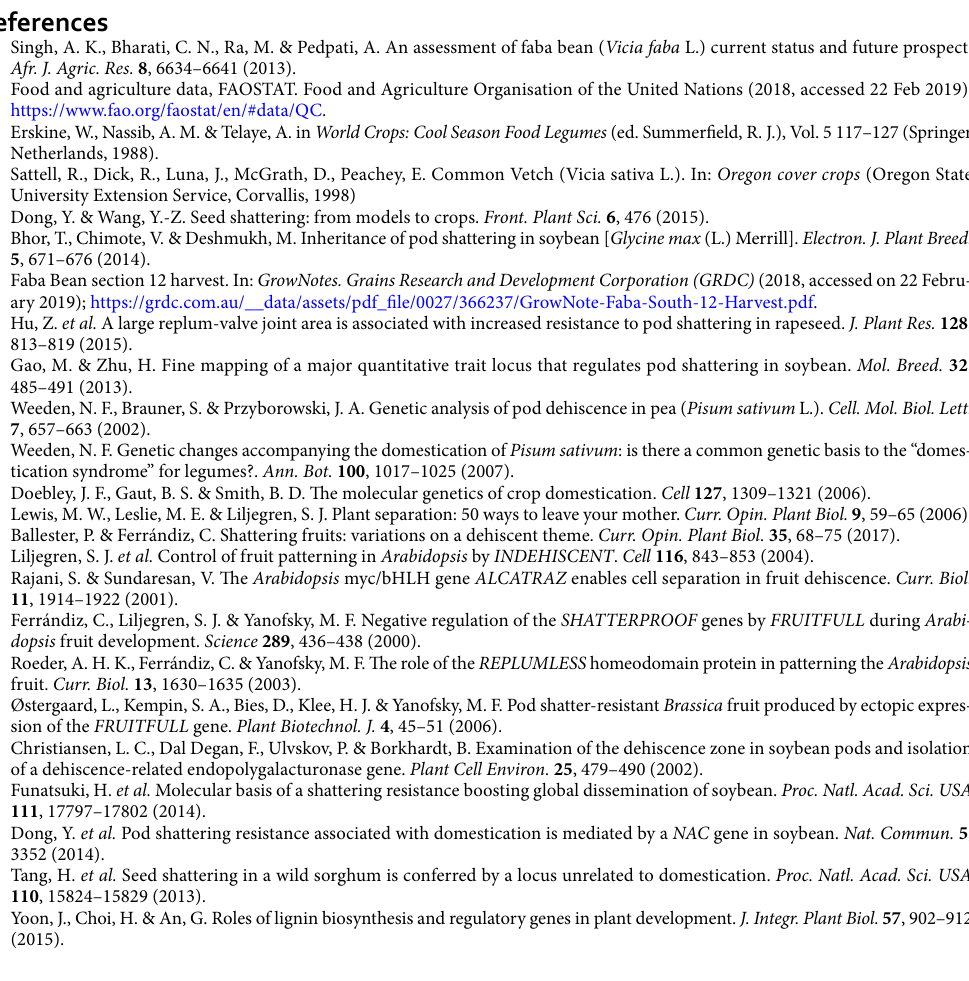
The area and perimeter of the lignified cell layer was measured in the left and right DZ regions. The percent- age of lignin inside the cells was calculated as (total cell area—inner non-colored area)/total cell area × 100, and was measured in 20 cells.